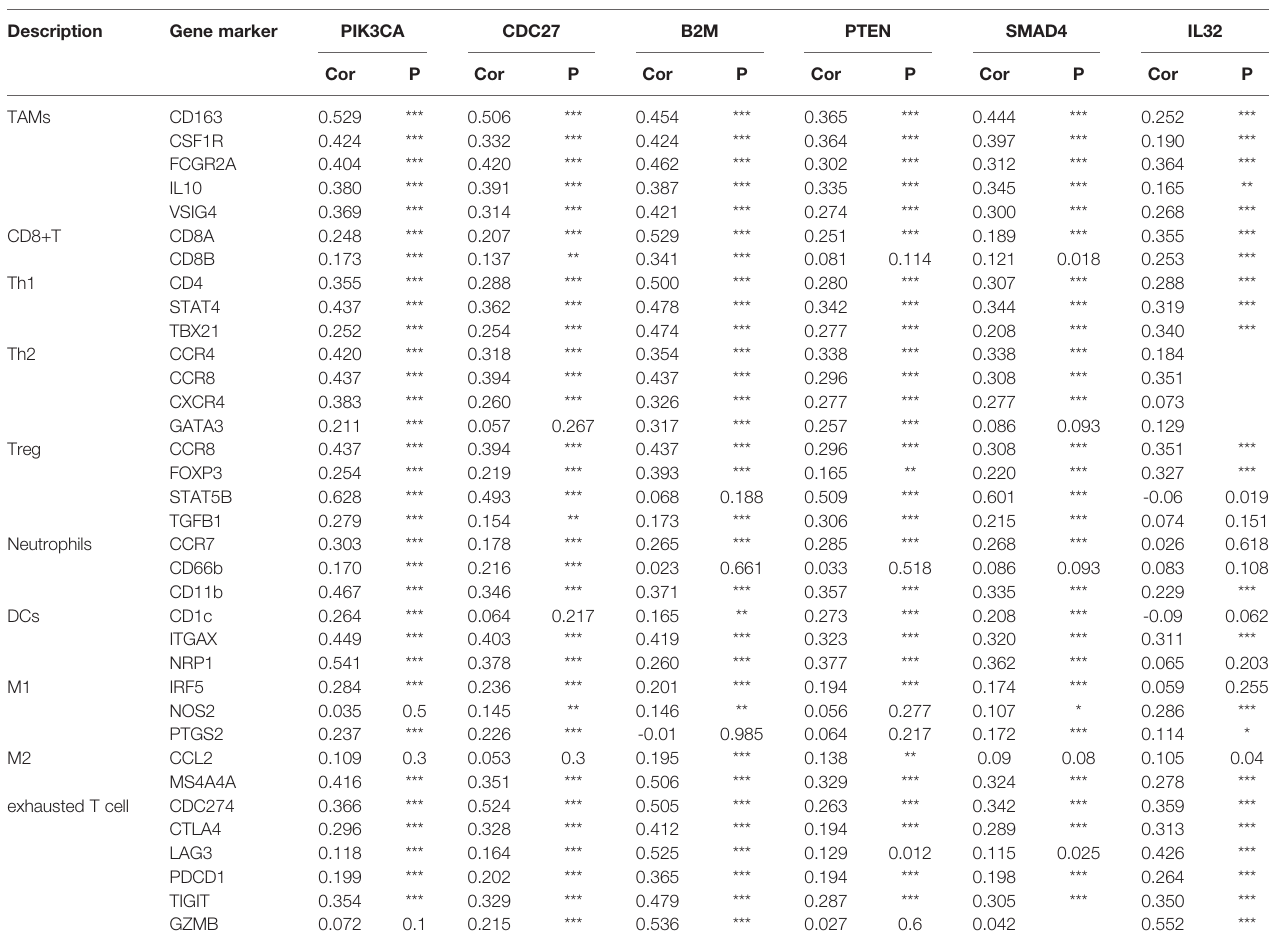
TABLE 1 | Correlation analysis between related genes and markers of immune cells.